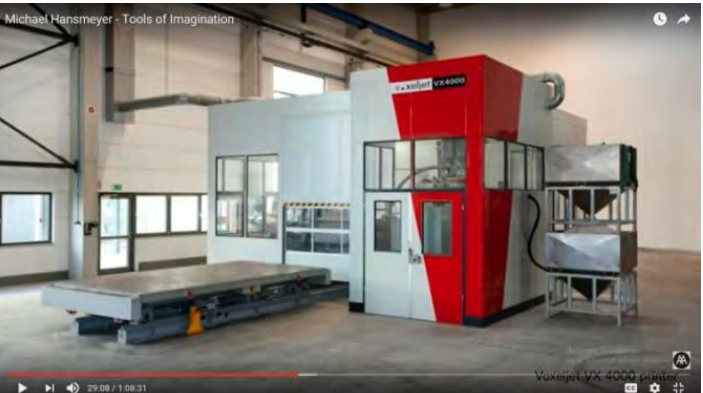
Figure 10. thegiant 3D printer